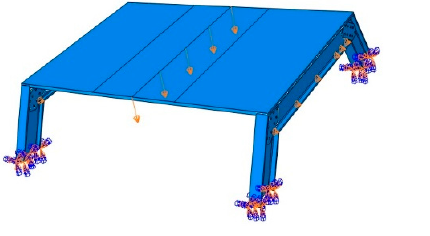
Table 6. The parameters of mortar-damaged plasticity [26].